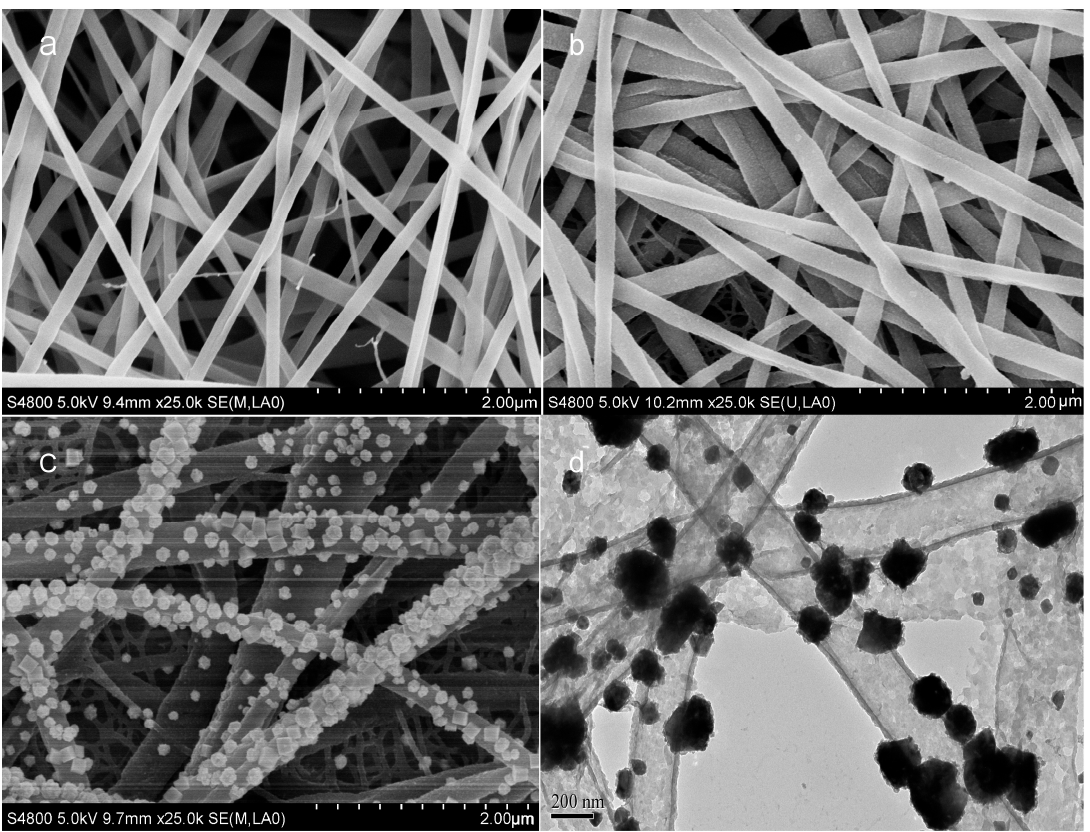
Figure 1. FE-SEM images of ( a ) PCL nanofibers; ( b ) PCL@PPy; ( c ) CuO/PCL@PPy; ( d ) TEM image of CuO/PCL@PPy.